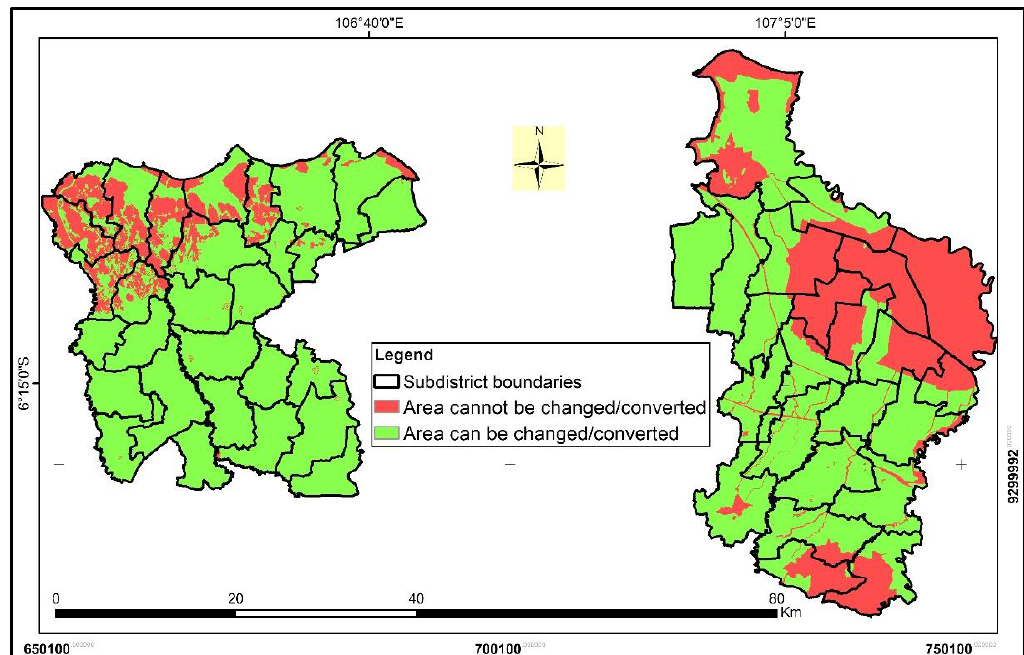
Figure 3. Spatial constraint map based on regency spatial plan. Table 1. A list of data used in this study.